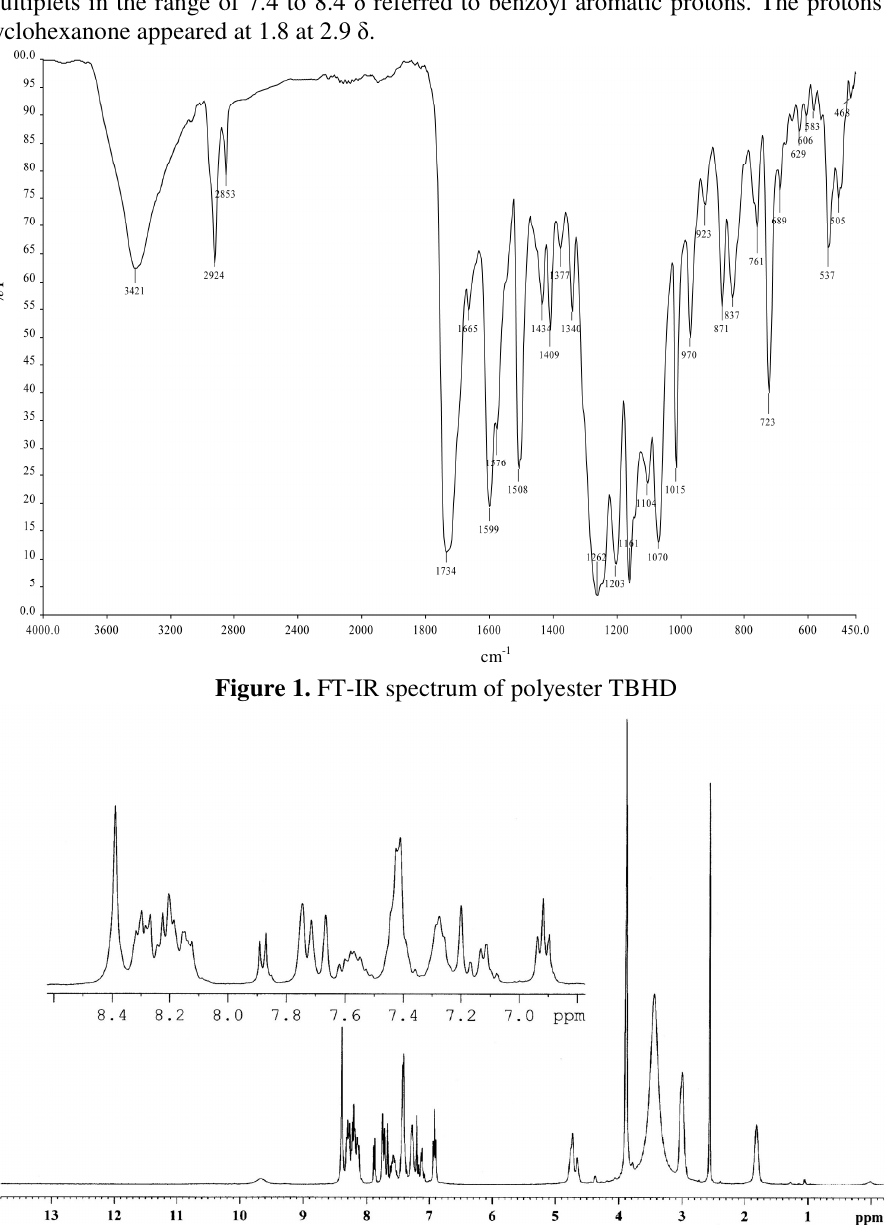
Figure 2. 1 H NMR spectrum of polyester